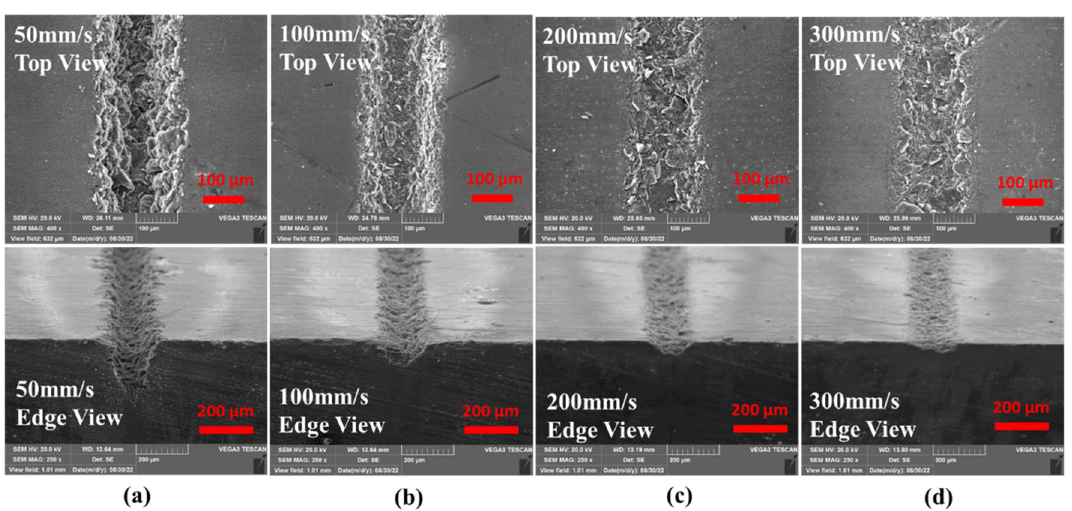
Figure 8. Effect of scanning speed on physical morphology; (a) 50 mm/s, (b) 100 mm/s, (C) 200 mm/s (d) 300 mm/s [Fixed: 20 kHz, 200 ns, 20W and 1pass].